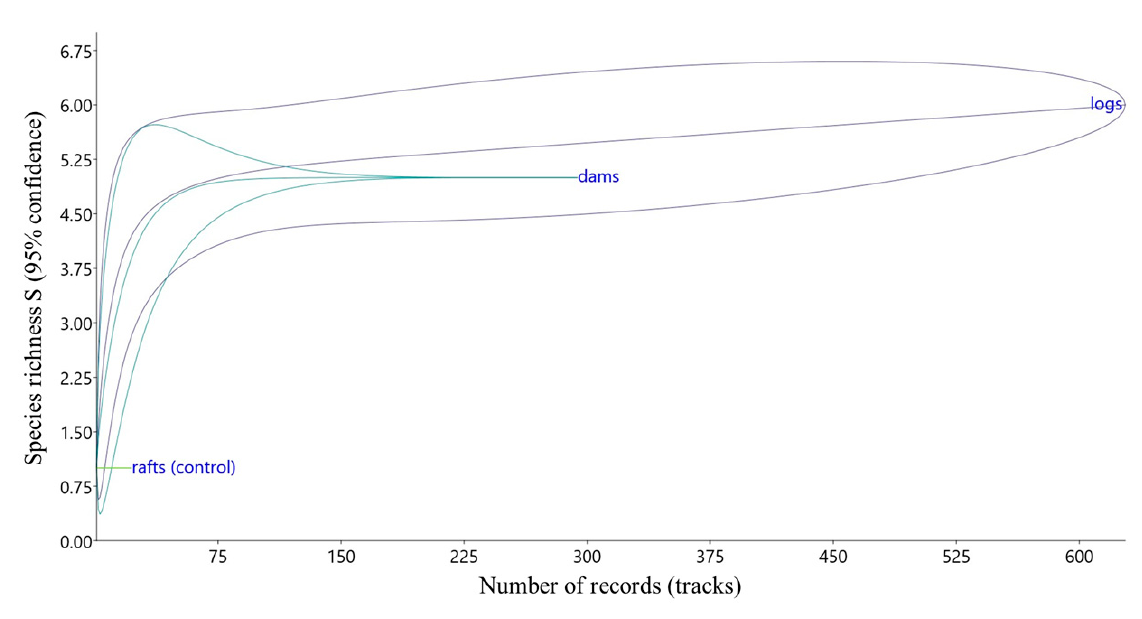
Figure 7. Individual rarefaction curves representing species richness (number of taxa) in particular categories of the tracking tunnels for all sites combined.